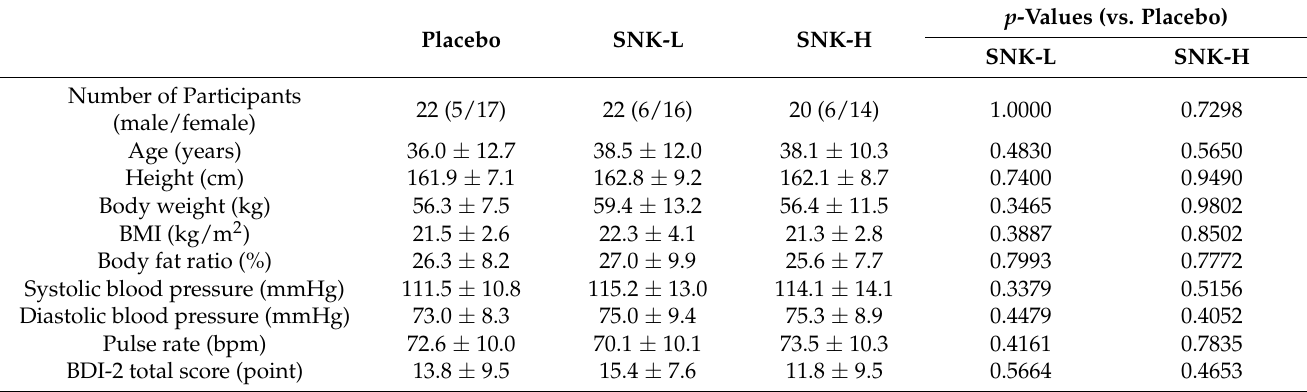
Figure 1. Flow diagram showing participant recruitment and data analysis. Table 2. Characteristics of the study